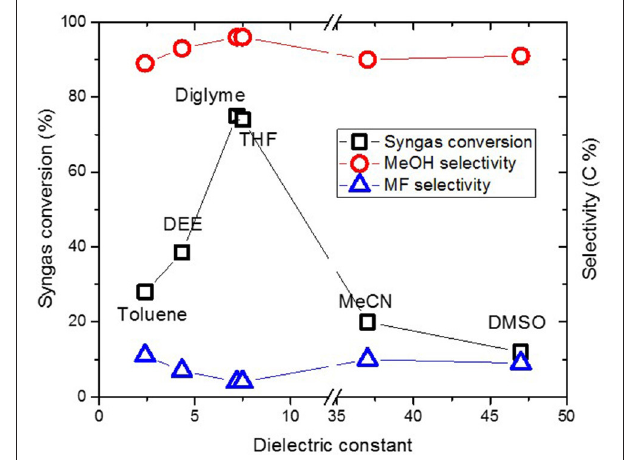
FIGURE 4 | Syngas conversion and selectivity versus dielectric constant of solvent in the “once through” Cu nanoparticles catalyzed reaction.